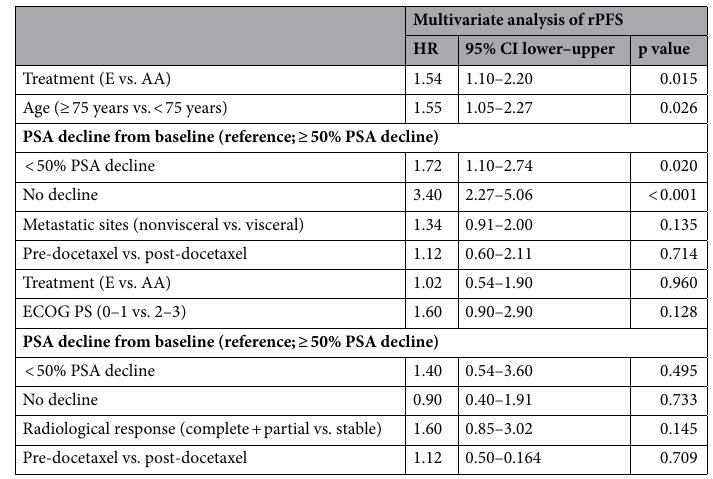
Table 4. Multivariate Cox regression analysis of rPFS and OS in all patient population. HR hazard ratio, CI confidence interval, E enzalutamide, AA abiraterone acetate, PSA prostate-specific antigen, ECOG-PS Eastern Cooperative Oncology Group-Performance Status, rPFS radiological progression free survival, OS overall